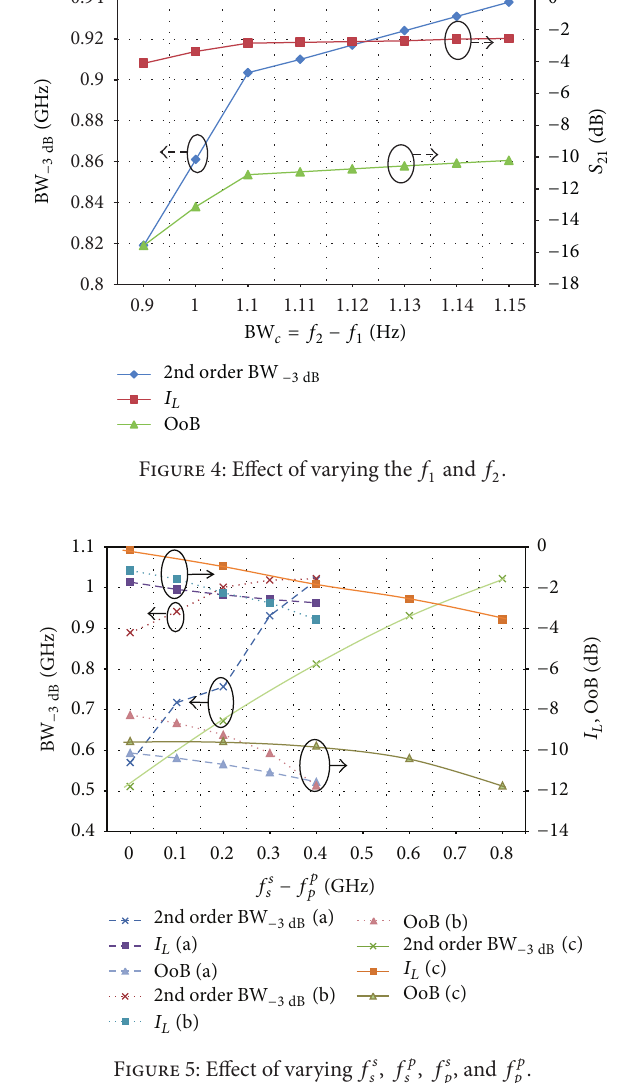
Figure 5: Effect of varying 𝑓 𝑠 𝑠 , 𝑓 𝑝 𝑠 , 𝑓 𝑠 𝑝 , and 𝑓 𝑝 𝑝 .